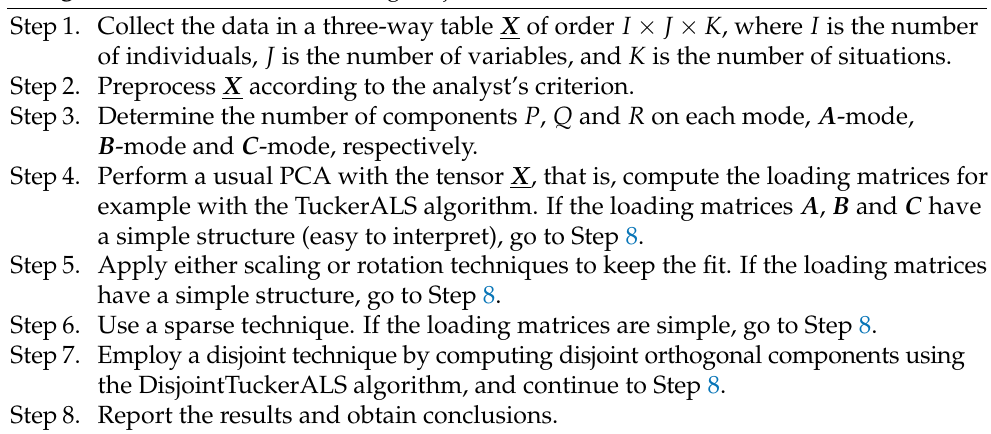
Figure 2. Flowchart of the DisjointTuckerALS algorithm that computes two disjoint orthogonal matrices (in this case the matrices B and C ). Algorithm 3: Procedure for using